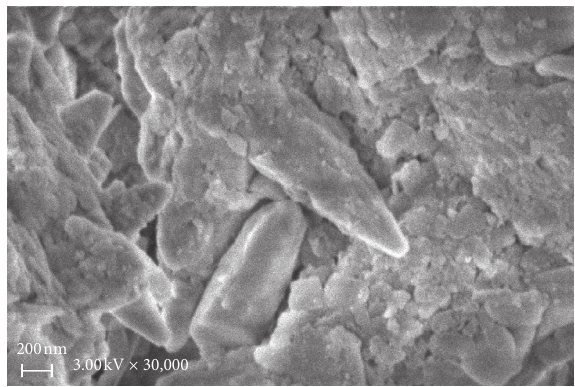
Figure 7: SEM image of 20% calcium carbonate-doped red